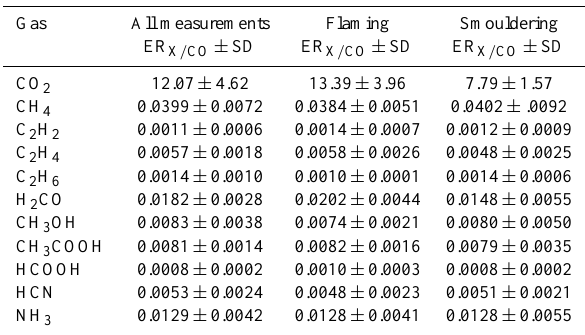
Table 3. Same as Table 2, but for mean emission ratios for com- pound X with respect to CO (ER X / CO )